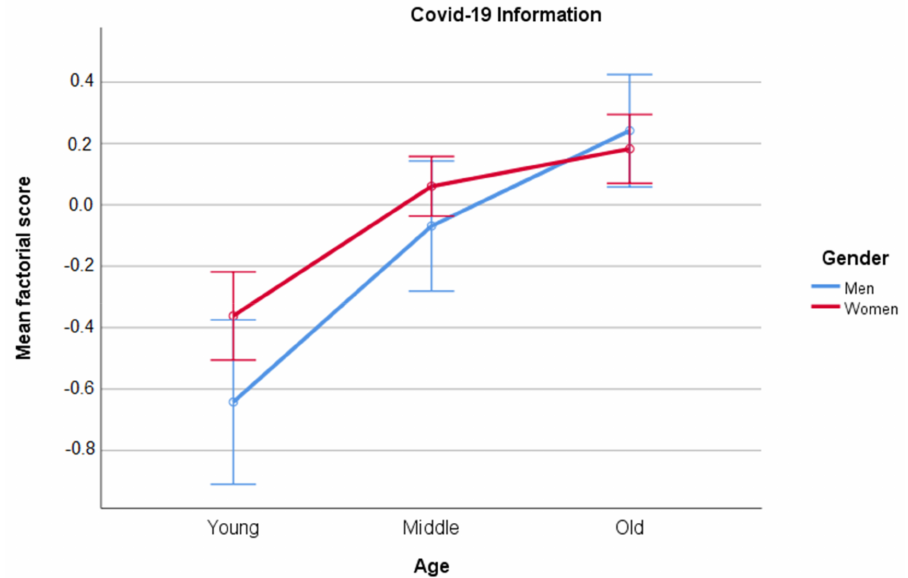
Figure 4. Means and confidence interval (95%) of factor scores for COVID-19 Information as a function of Gender and